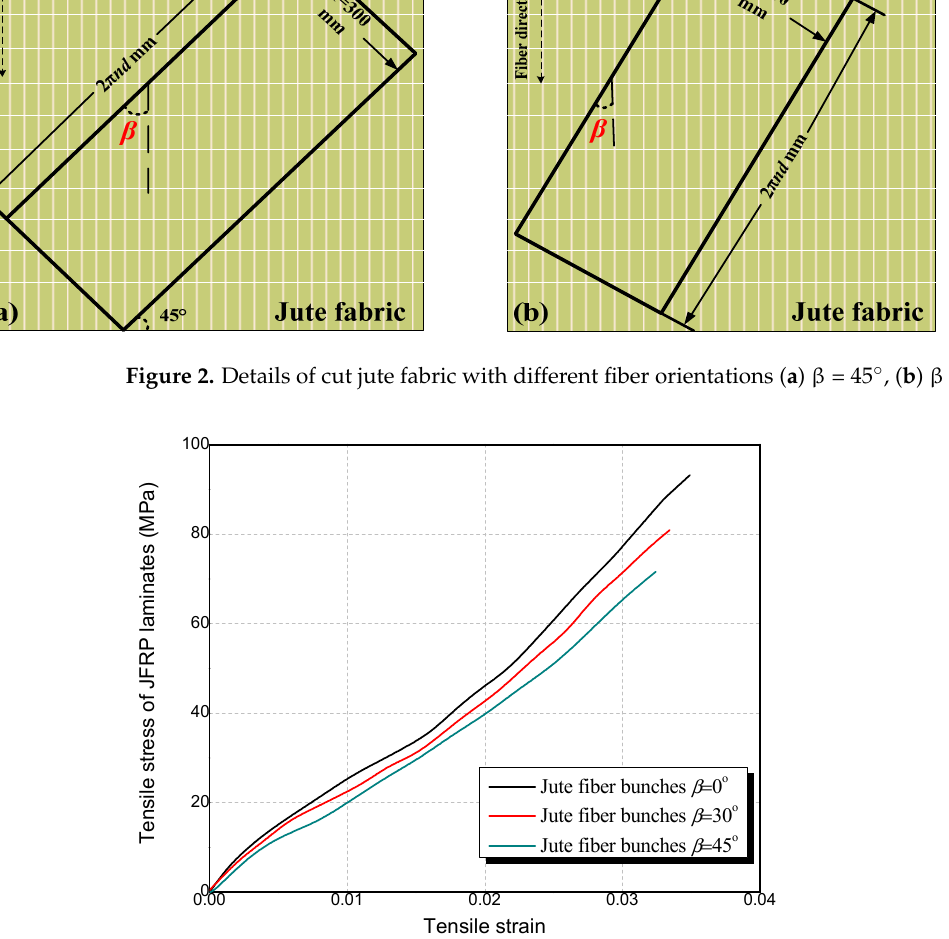
Figure 3. Tensile stress–strain of JFRP laminates. Table 5. Mechanical properties of JFRP laminates.